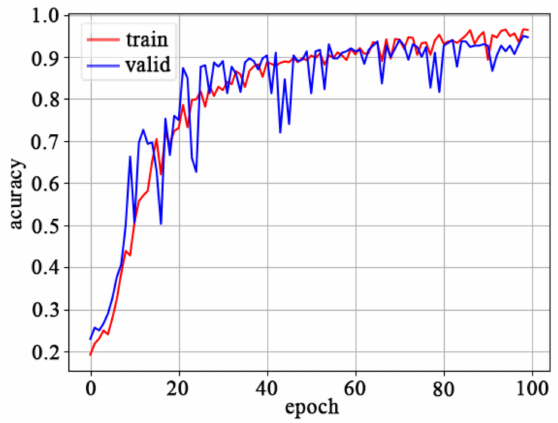
Figure 10. Training accuracy and valid accuracy.